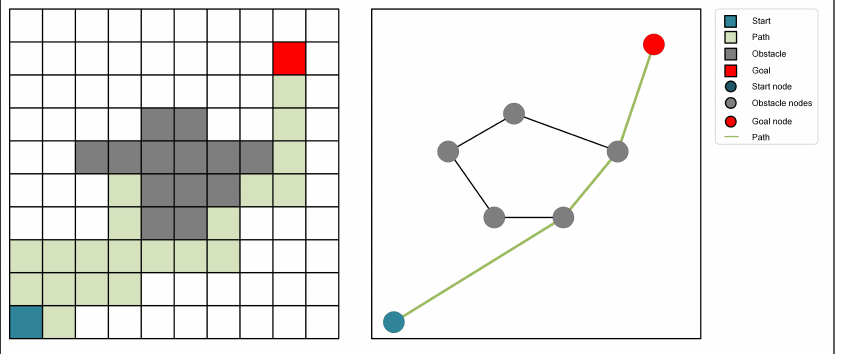
Figure 1. Comparison of the occupancy grids and the visibility